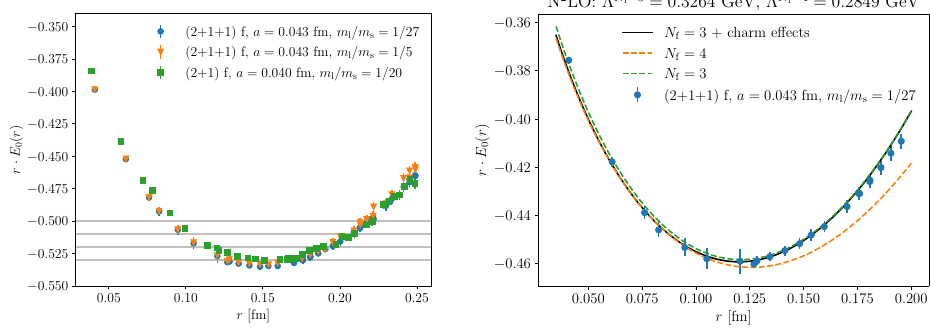
Figure 4. Left: The dimensionless quantity rE 0 ( r ) for two different (2 + 1 + 1)-flavor ensembles using different light quark masses and one (2+1)-flavor ensemble of similar lattice spacing. Right: Comparison of the (2+1+1)-flavor data with curves obtained from different perturbative expressions of the static energy times the